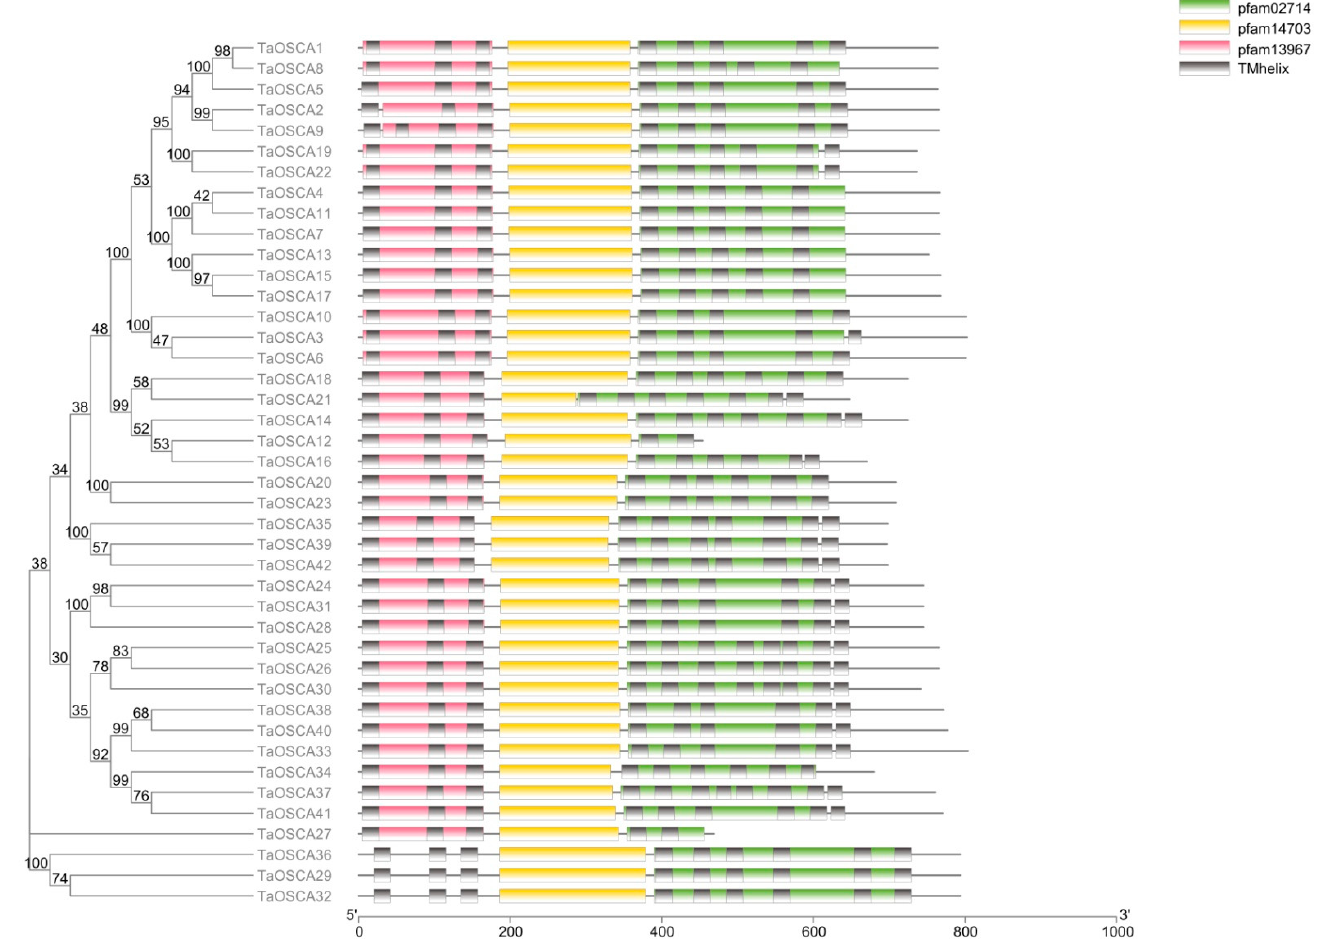
Figure 3. Analysis of conserved domains in TaOSCA proteins. Pink, yellow, green, and gray boxes represent the pfam13967, pfam14703, pfam02714, and transmembrane helix domain, respectively.